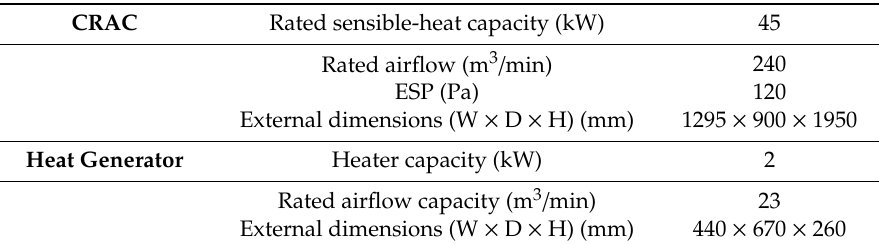
Table 2. Overview of experimental